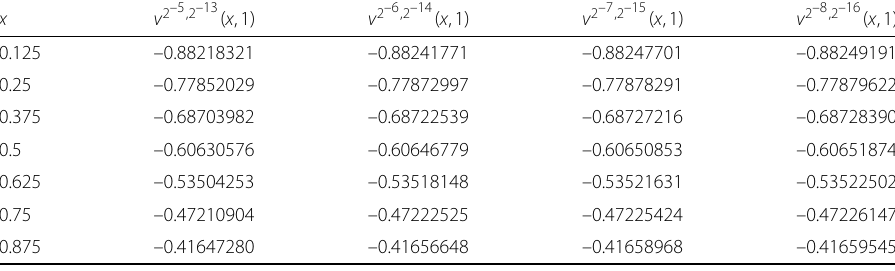
Table 4 The approximate solution ˜ v at some grid points on t = 1 for Example